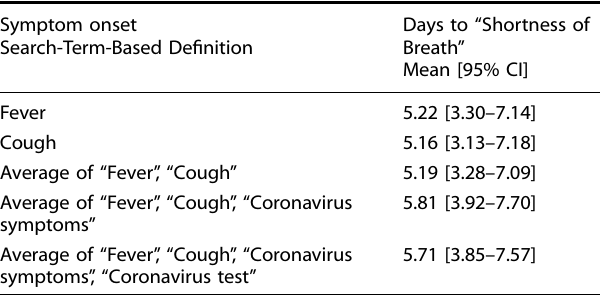
Table 2. Different search-term-based de fi nitions for symptom onset were examined by looking at different combinations of early-peaking search terms.